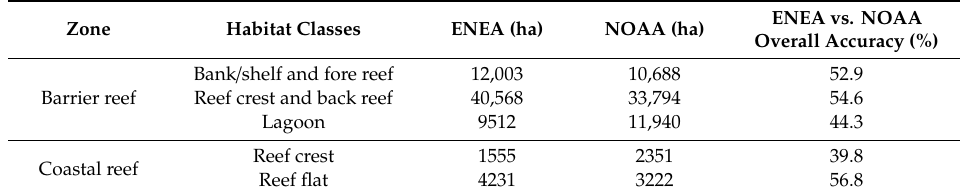
Table 4. Palau: Habitat classes cover (ha) in the two zones of the barrier reef (site no. 1) and coastal reef (site no. 2) computed for the 2017 in the present work (ENEA) and by NOAA (Analytical Laboratories of Hawaii, 2007) in 2004. Di ff erences in accuracy are in percent